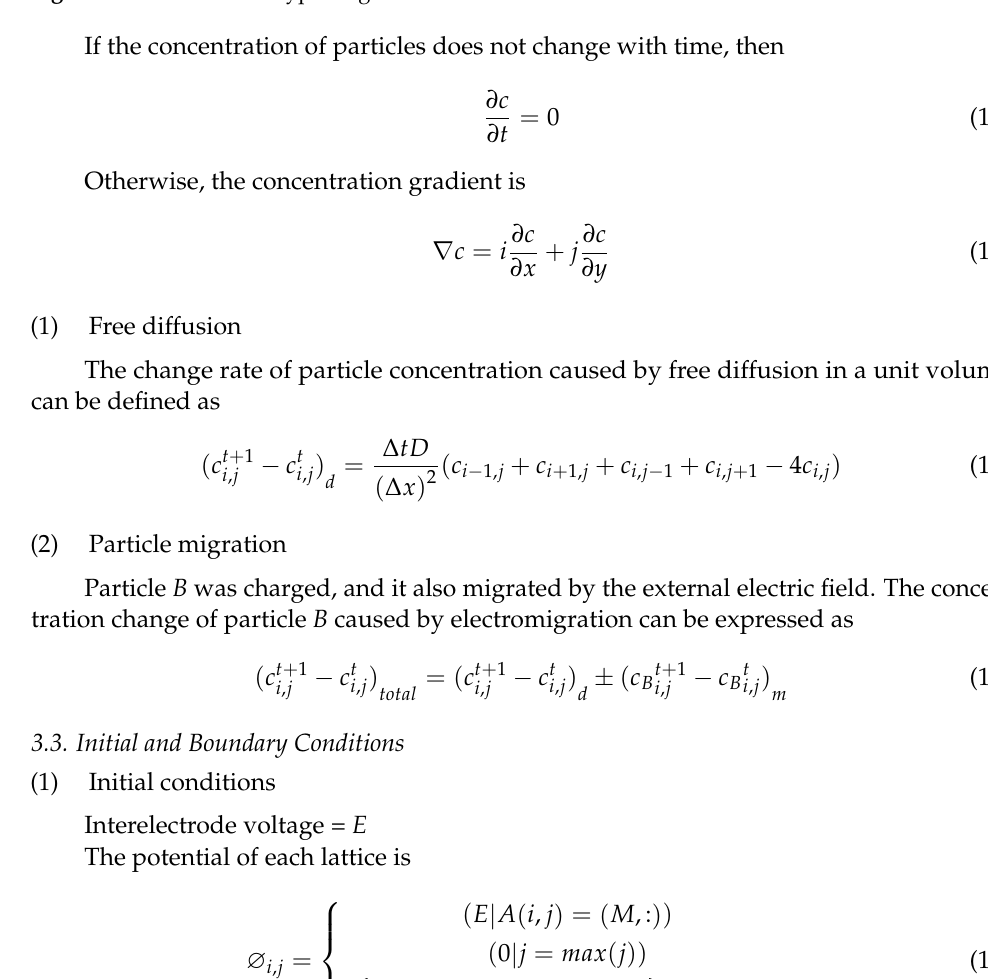
Figure 3. Von Neumann-type neighborhood for a lattice.